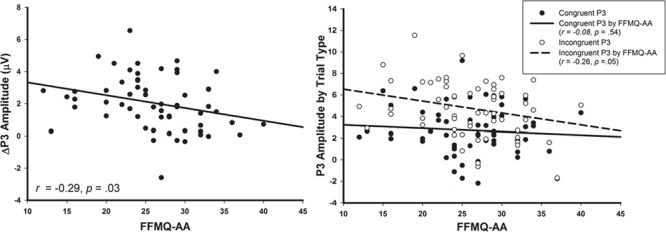
Scatterplots depicting P3 amplitude as a function of trait mindfulness (FFMQ-AA). Left: negative correlation between congruency difference (incongruent–congruent) in P3 amplitude (ΔP3) and FFMQ-AA, such that as FFMQ-AA increases, ΔP3 decreases. Right: significant negative correlation detected between FFMQ-AA and P3 amplitudes elicited on incongruent (dotted line), but not congruent trials (solid line). As FFMQ-AA increases, P3 amplitudes elicited on incongruent trials decreases.